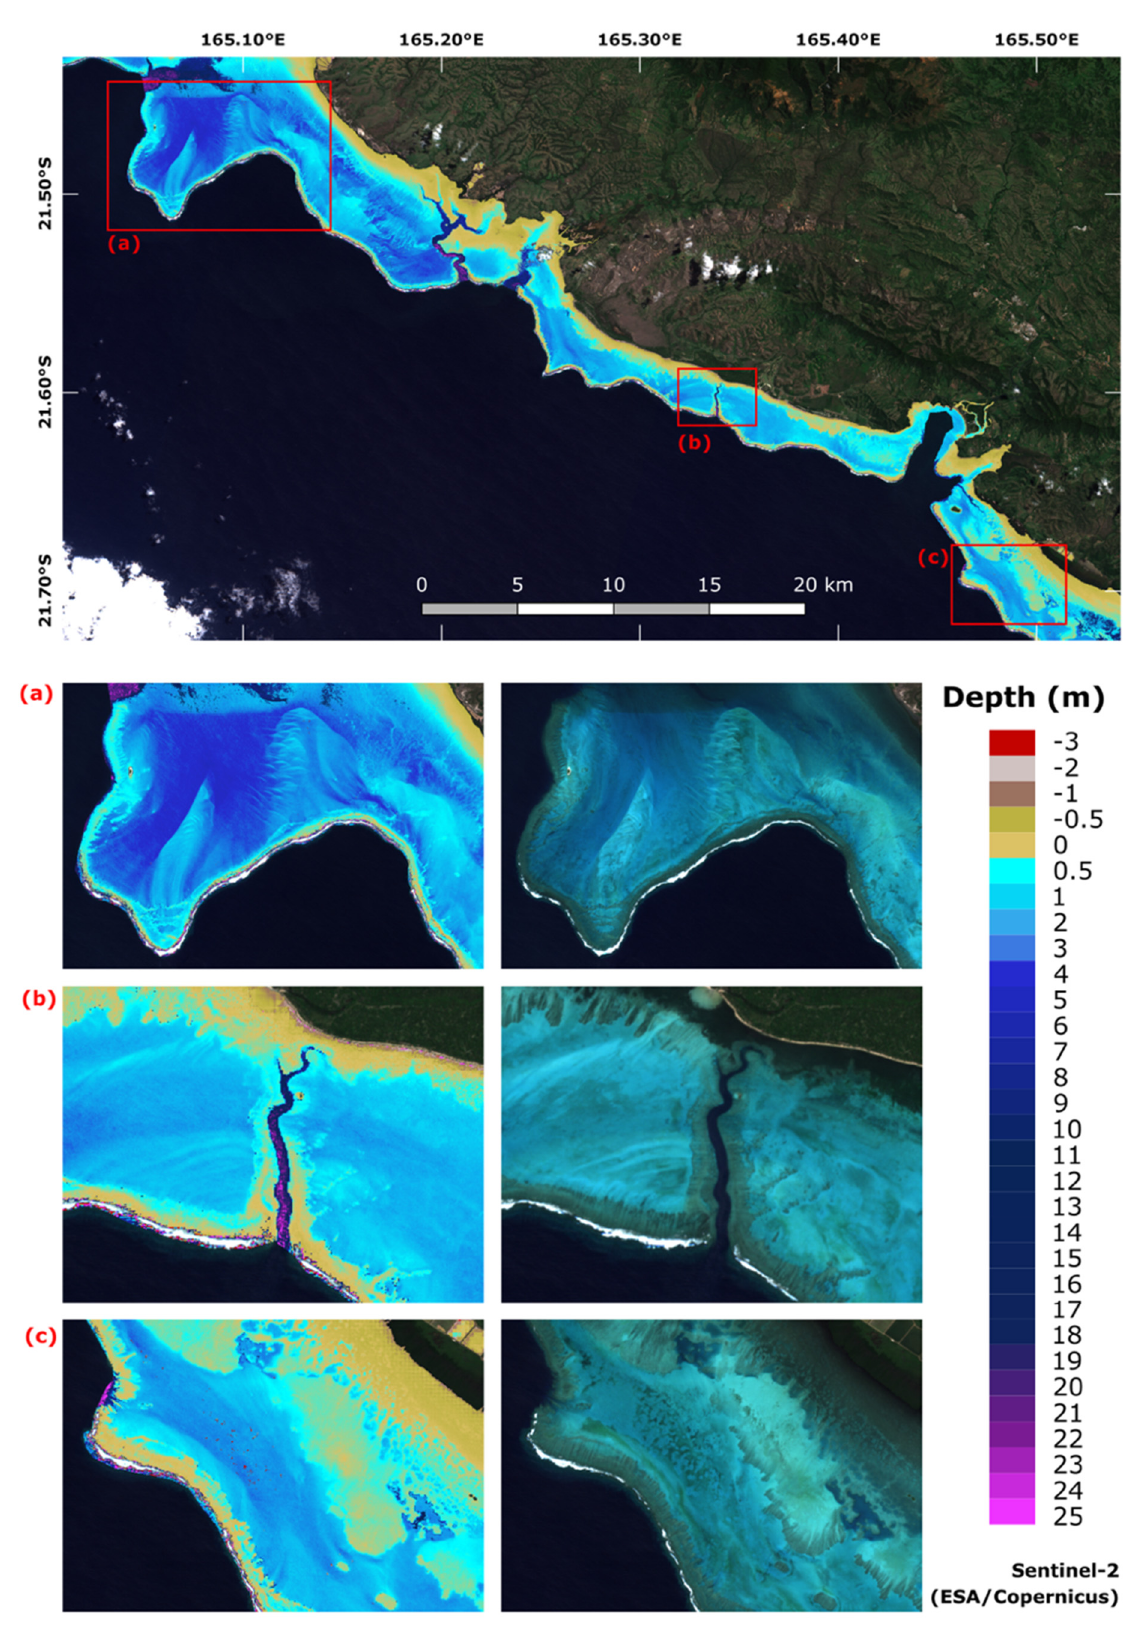
Figure 8. Up –Application of the IMBR model over the footprint of the same Sentinel-2 scene processed for the Poe lagoon. ( a ) zoom on the Poya lagoon; ( b ) zoom on the Sharks fault and surroundings; ( c ) zoom on the Moindou lagoon.